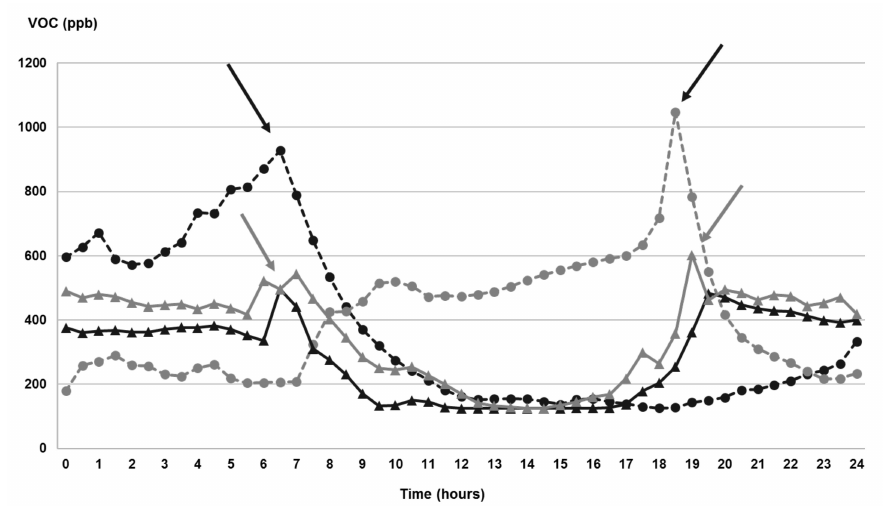
Figure 2. Daily (10 February 2020) evolution of VOCs concentration in each investigated room. Points (dashed lines) represent kitchens and triangles (full lines) bedrooms; black symbols and lines correspond to flat 1; light grey symbols and lines correspond to flat 2. Arrows indicate the occupant activities: black arrows indicate occupants’ cooking activities, while light grey ones indicate go to bed/wake